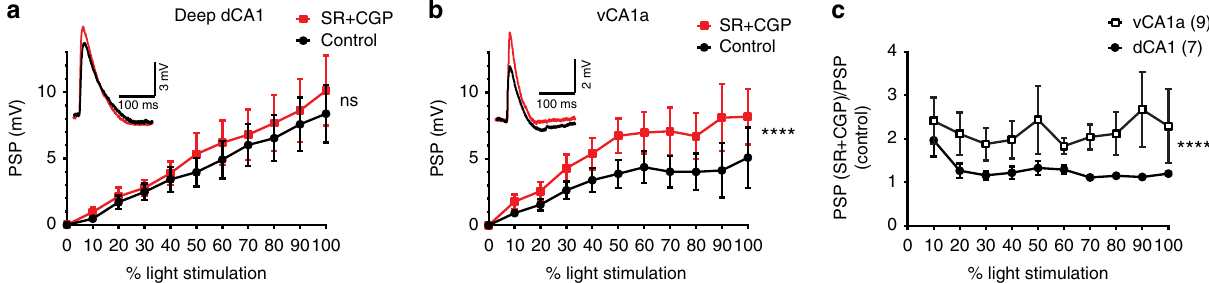
Fig. 7 dCA2 inputs recruit more disynaptic inhibition in vCA1a than in deep dCA1. AAV-DIO-ChR2-eYFP was injected in dCA2 of Amigo2 -Cre mice. a Synaptic input-output curves following photostimulation of dCA2 inputs at indicated intensities in deep dCA1 PNs, before and after blockade of GABA